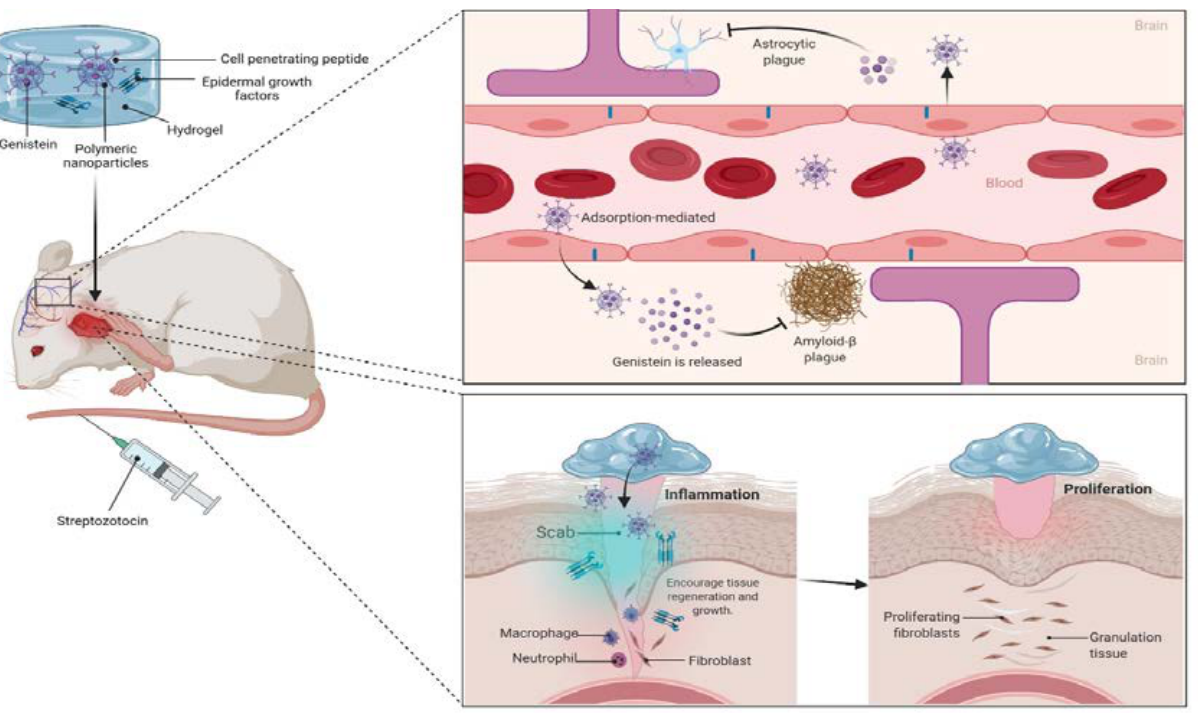
Figure 5. Future perspectives of hydrogel loaded epidermal growth factors with genistein-polymeric nanoparticles for effective wound healing and inhibition of amyloid beta plague.